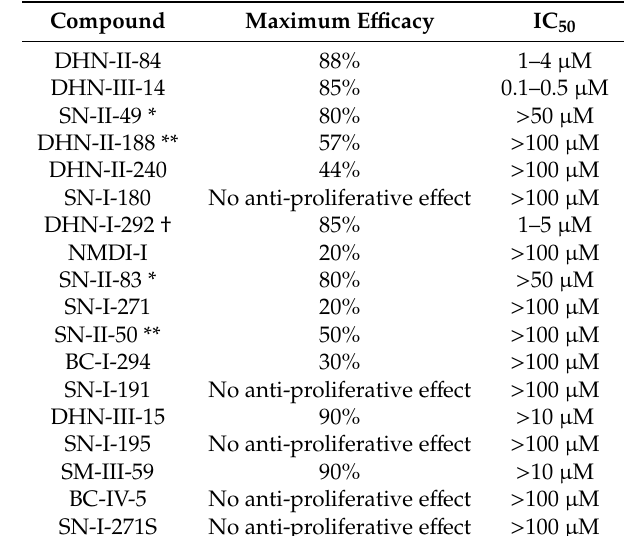
Table 1. Maximum e ffi cacy and IC 50 values for the 18 compounds initially screened for anti-proliferative e ff ects in three NET cell lines (H727, TT, MZ-CRC-1).